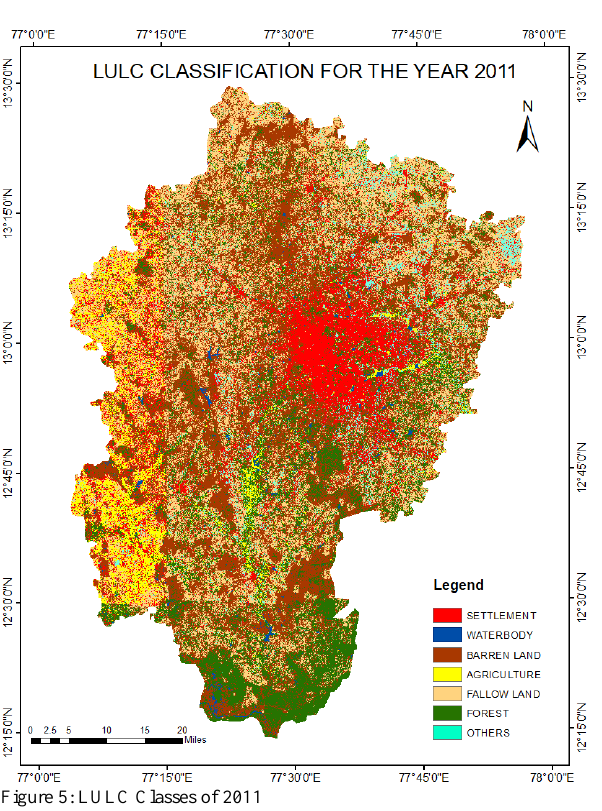
Figure 5: LULC Classes of 2011